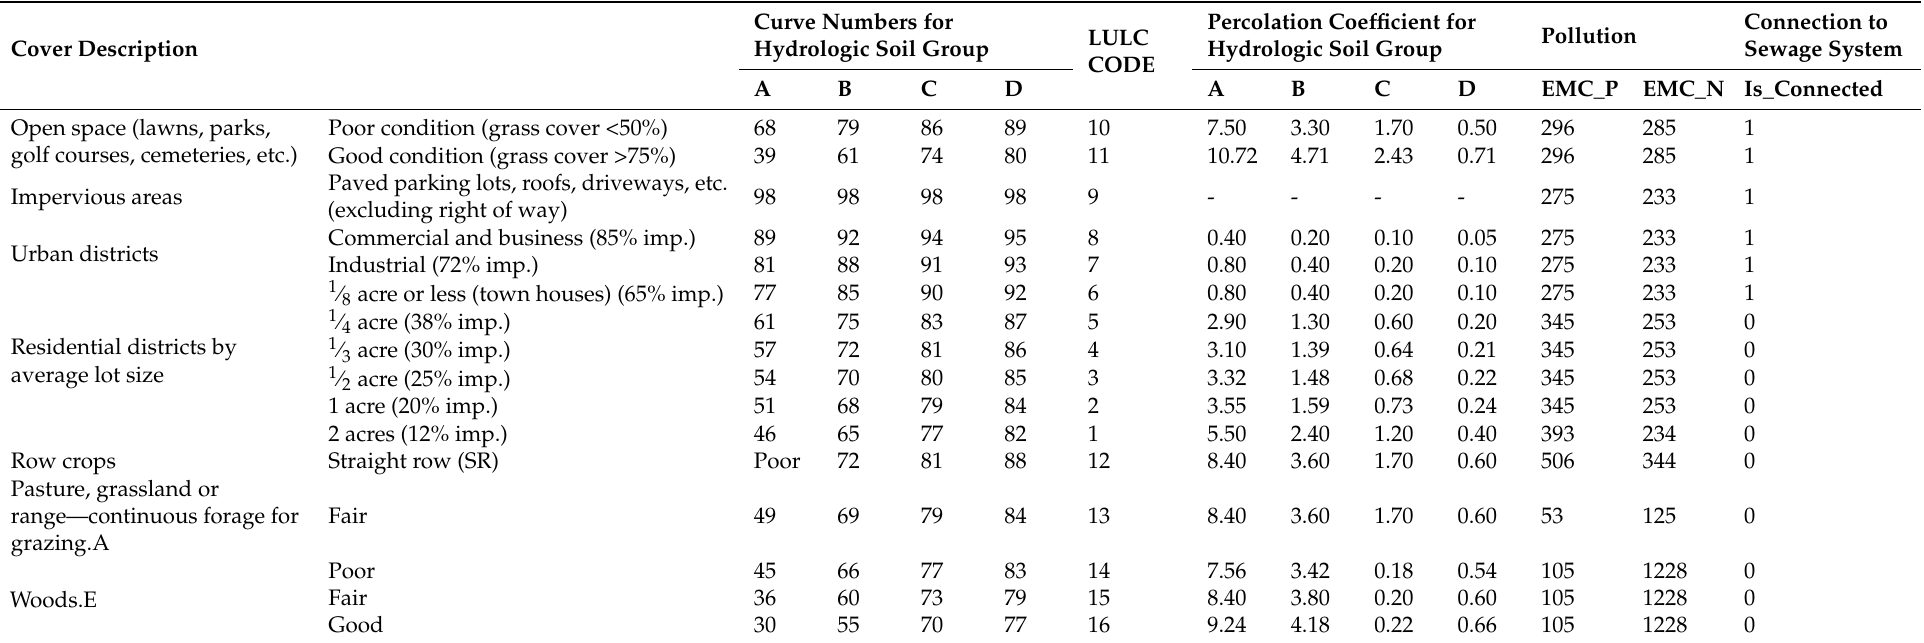
Table 4. Biophysical table for both models (the urban flood risk mitigation model uses only the curve numbers for the hydrologic soil group). The source of parameters for percolation and pollution can be found in: InVEST User’s Guide available at: https://invest-userguide.readthedocs.io/en/latest/urban_flood_mitigation.html (accessed on 14 January